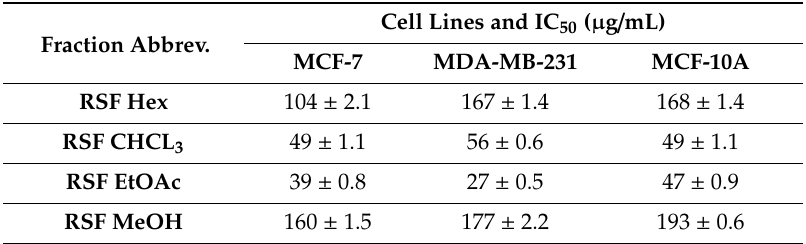
Table 1. Comparison of IC 50 values for the di ff erent R. stricta fruit fractions towards MCF-7, MDA-MB-231 and MCF-10A breast cancer cell